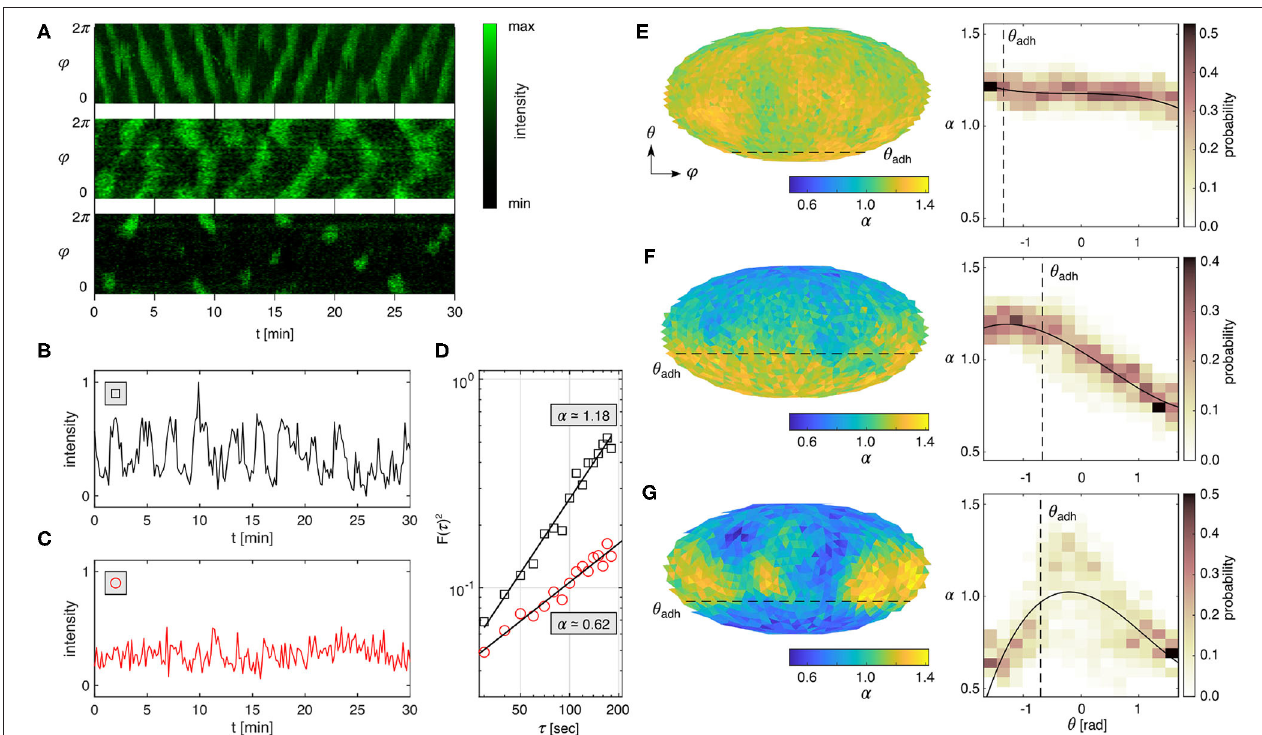
FIGURE 2 | Spatial fluctuation analysis of PIP3 Dictyostelium membrane signals. (A) PIP3 dynamics recorded on the membrane periphery of Dictyostelium cells. Horizontal propagating waves ( top panel ), vertical propagating waves ( middle panel ), transient spot waves ( bottom panel ). Periodic signal (B) and noisy signal (C) taken at a membrane site that adheres to the substrate that correspond to the examples shown in (A) top and bottom panels, respectively. (D) Detrended fluctuation analysis of the signals shown in (B,C) showing noisy signal ( α 1.18) and noise without detectable signal ( α 0.62). (E–G) Mollweide maps of α for the three ≃ ≃ different prototypical PIP3 domain dynamics shown in (A) . The right panels show the respective histograms along the horizontal direction ( θ ) and the weighted polynomial fit (black solid line). The black dashed lines indicate the contact perimeter ( θ adh ) of the Dictyostelium